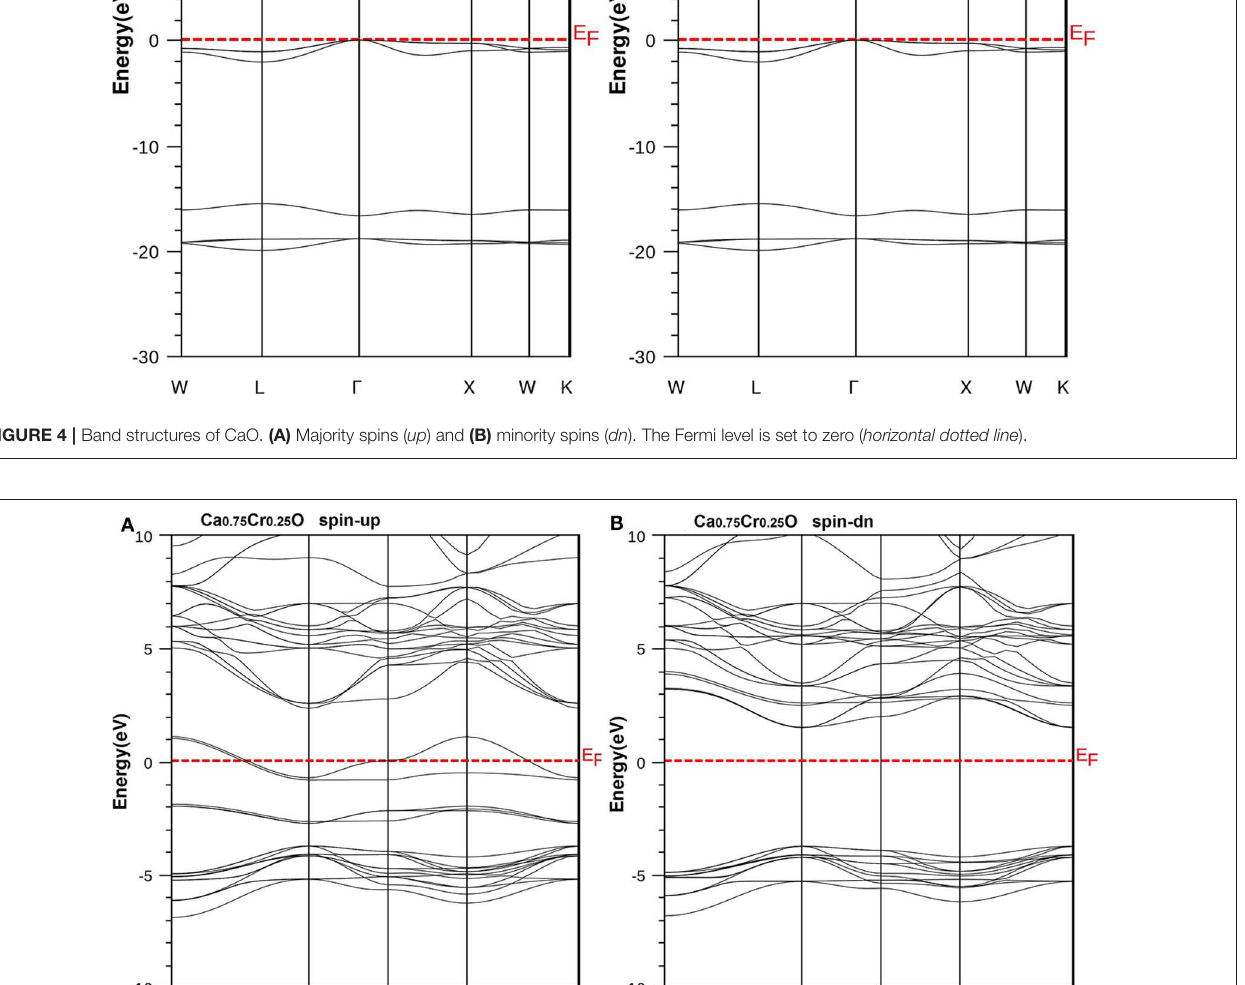
( E HMF ) and HM gaps ( E HM ) of Ca 0.75 Cr 0.25 O, Ca 0.5 Cr 0.5 O, and Ca 0.25 Cr 0.75 O, and the indirect gap ( E Ŵ X ) of CaO with other theoretical (Fan et al., 2015; Nejatipour and Dadsetani, 2015; Yang et al., 2016; Tran and Blaha, 2017; Salam, 2018) and experimental data (Whited et al., 1973). The result of wide- indirect gap of 5.392 eV of CaO is in good agreement with recent calculated value of 5.35 eV of Tran and Blaha (2017) study using the same TB-mBJ potential (Becke and Johnson, 2006; Tran and Blaha, 2009), and it is better than the values ranging from